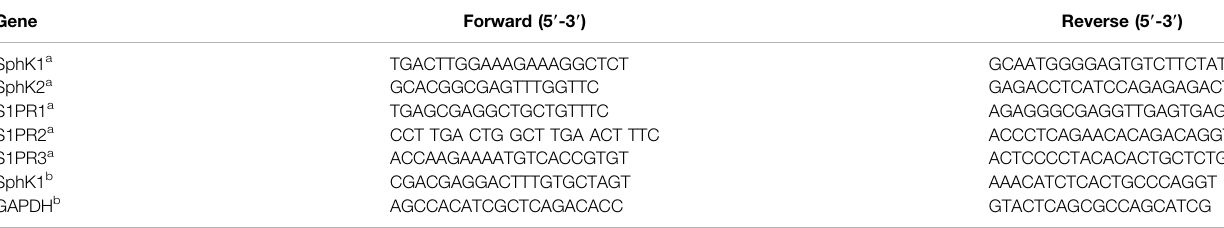
TABLE 1 | Primer sequences for